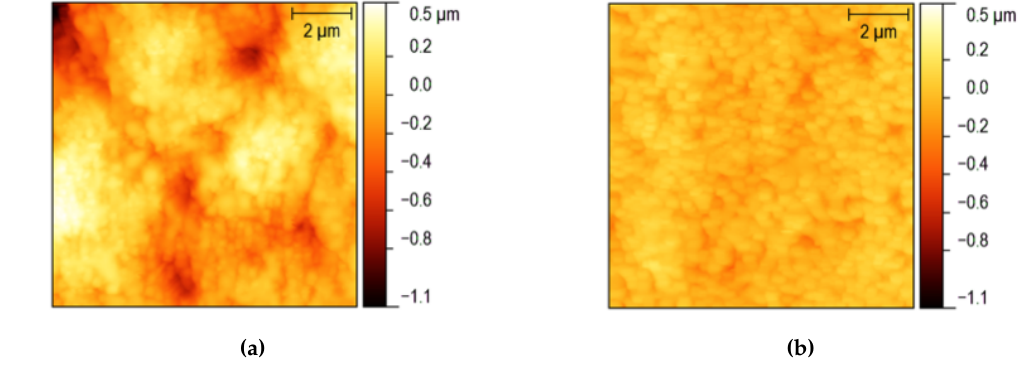
Figure 4. AFM images of the test samples with the lowest roughness obtained by laser ablation. The process parameters are E = 5 µ J and v = 500 µ m/s, and the images refer to the lateral wall ( a ) and the channel bottom ( b ). The colour scale is the same for both of the images in order to allow for a better comparison.